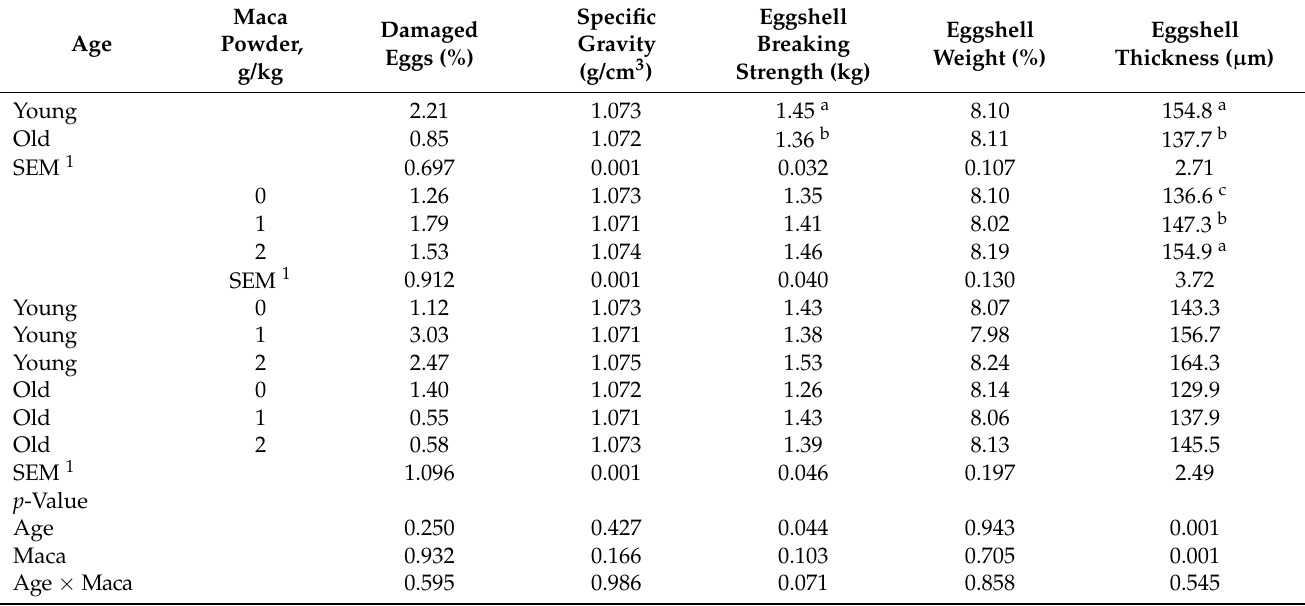
Table 3. Effects of Maca powder supplementation in diets of laying quails at different ages on eggshell quality